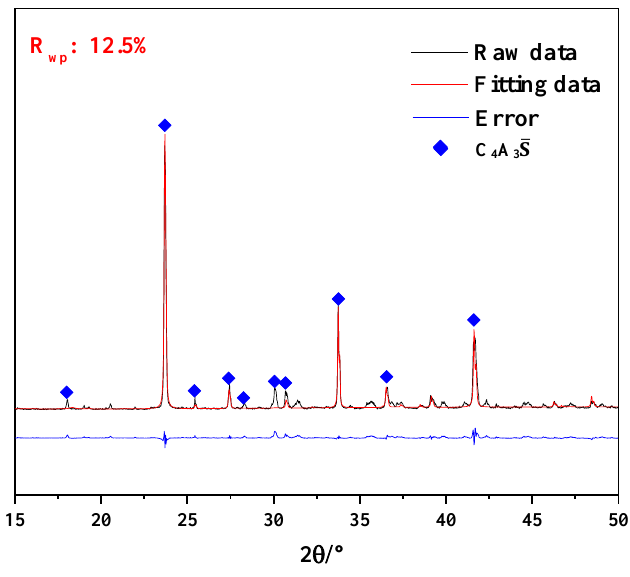
Figure 1. XRD patterns of C 4 A 3 S̅.